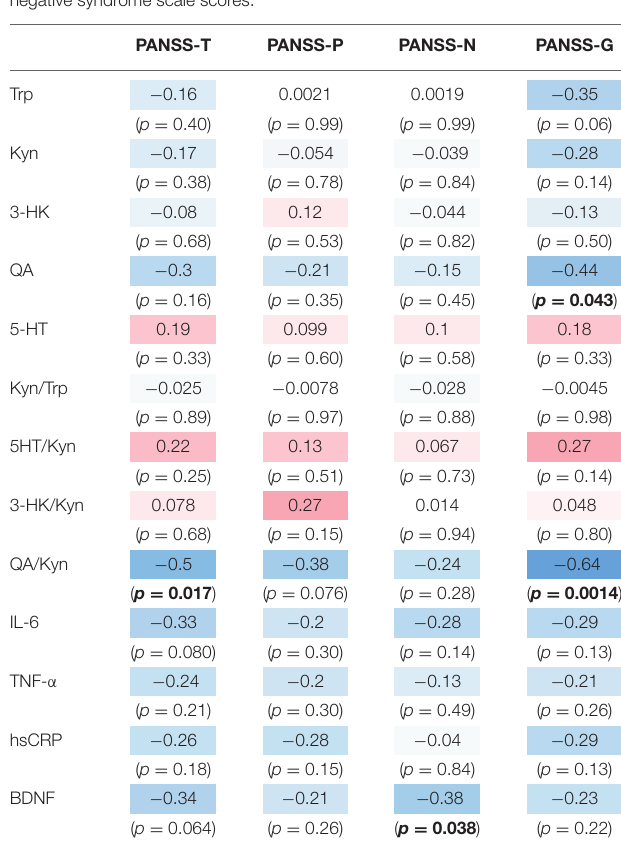
TABLE 5 | Relationship between metabolites of the Kyn pathway and positive and negative syndrome scale